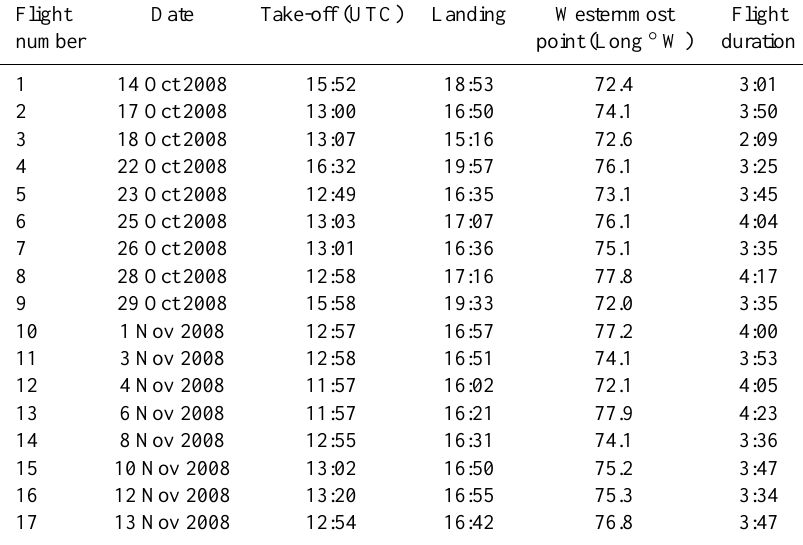
Table 1. Date and time of DOE G-1 research flights during VOCALS-REx ∗